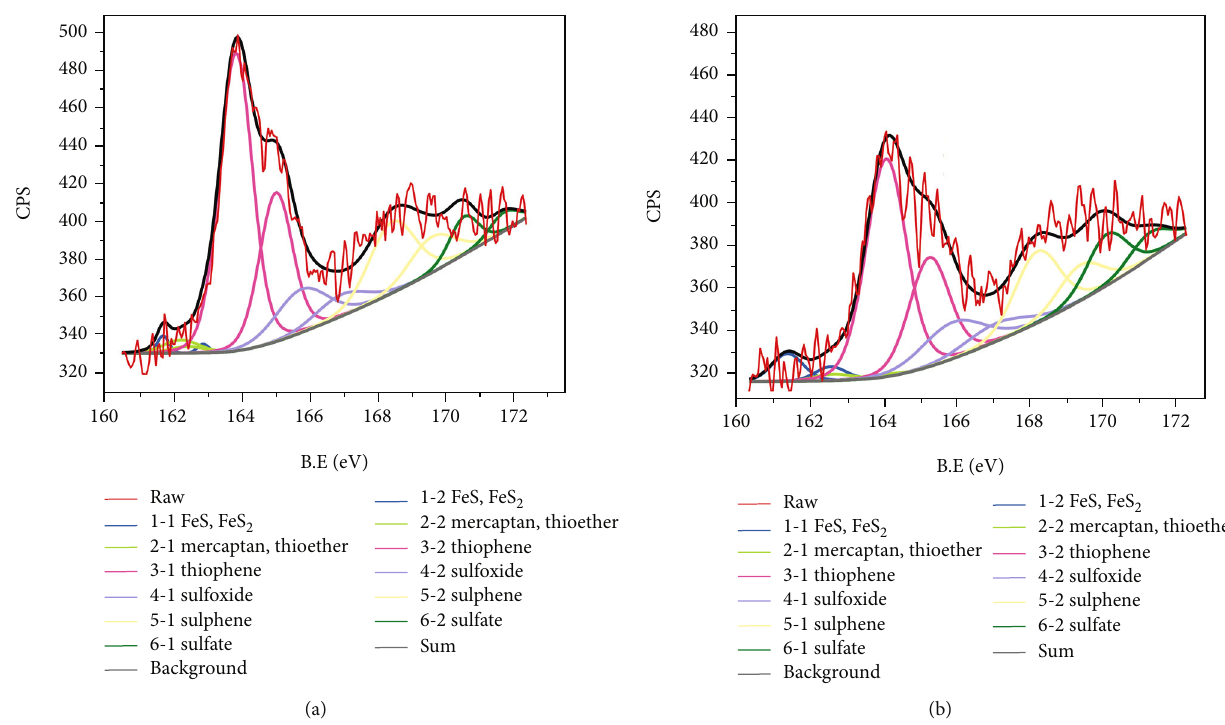
Figure 10: XPS spectrum of elemental S before and after H Table 2: Distribution of sulfur-containing functional groups before and after H Coal